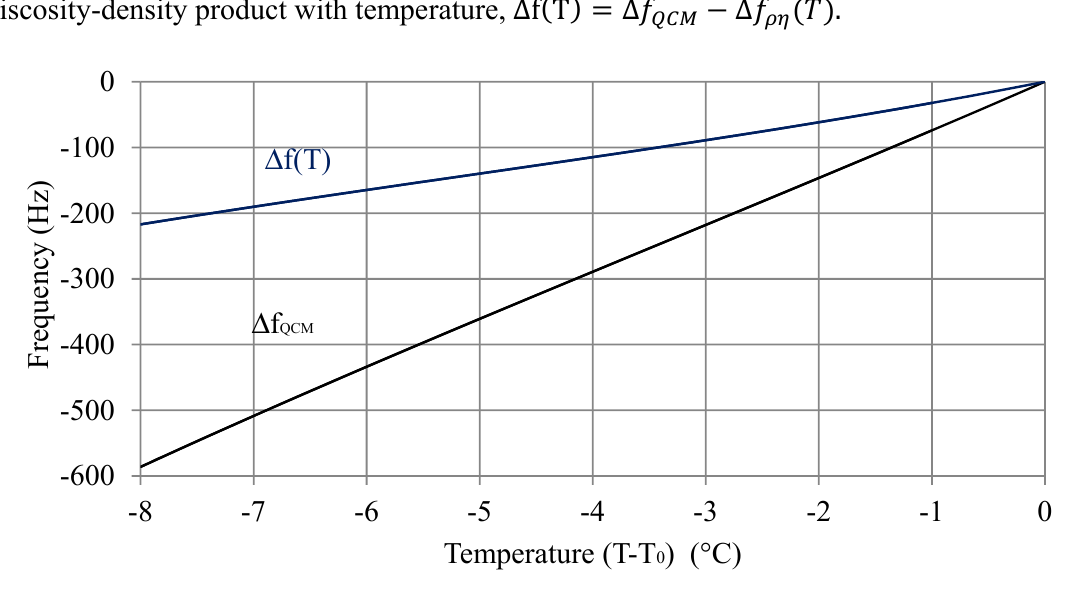
Figure 3. Variation of the oscillation frequency with temperature in a fully charged battery (40% sulphuric acid), Δ(cid:1858) , and compensation of the variation of the square root of (cid:3018)(cid:3004)(cid:3014)